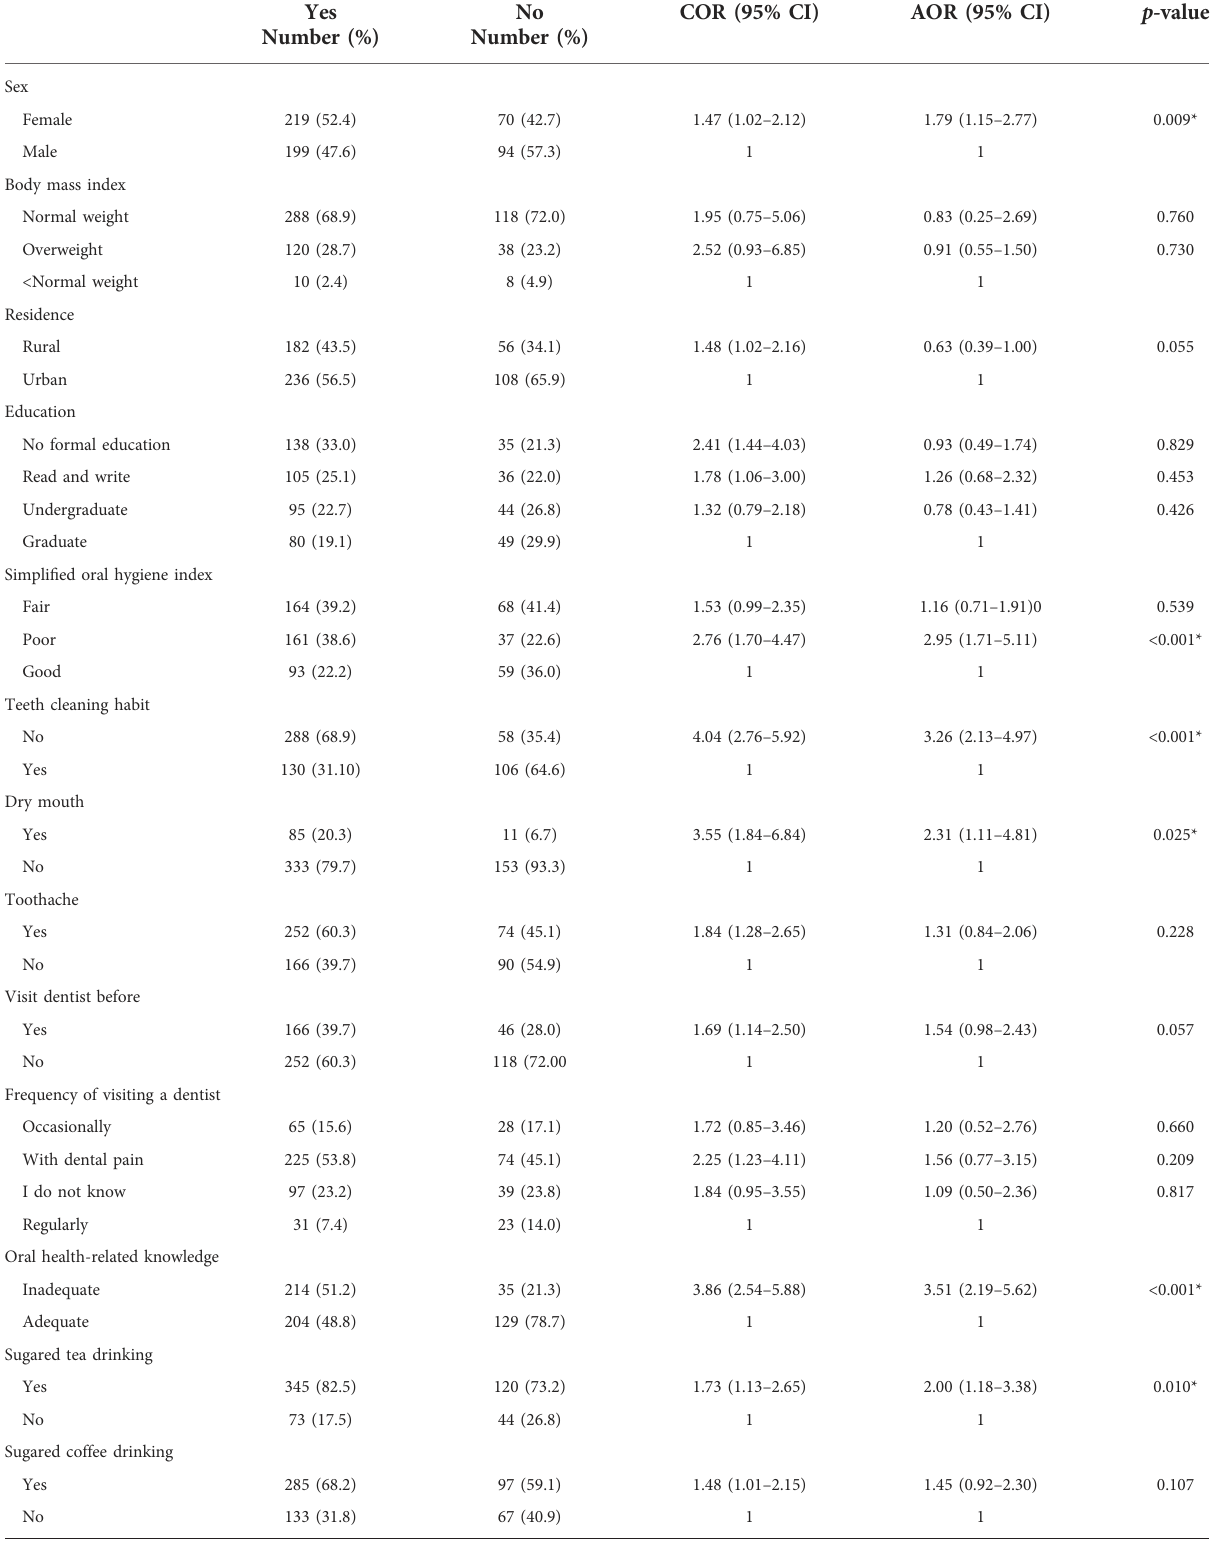
TABLE 6 Associated factors of dental caries among study participants attending the outpatient department in BPH, Northwest Ethiopia, 2019.